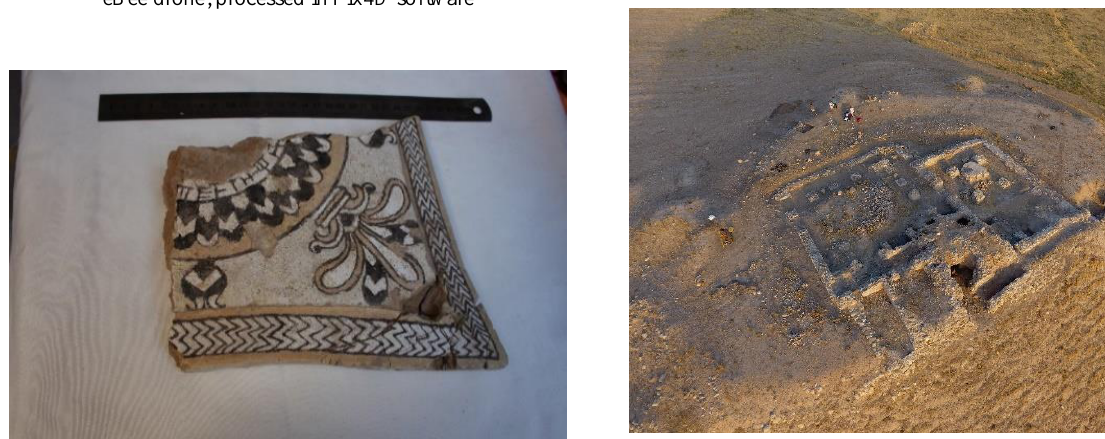
Figure 2. View of 3D model of the Satu Qala archaeologic site,